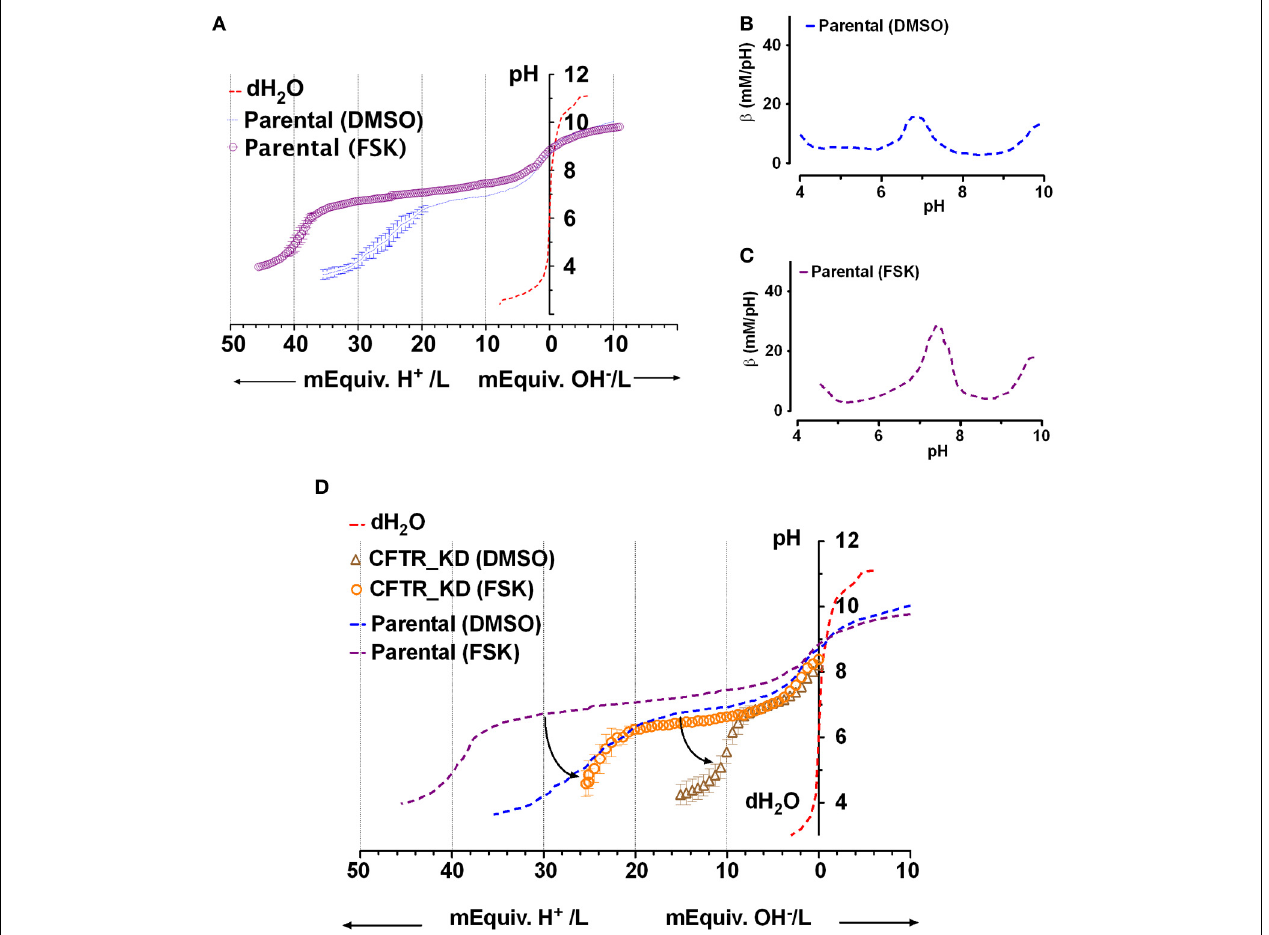
FIGURE 3 | Titration curves for Calu-3 secretions. (A) Microtitration of fluid producedbyparentalCalu-3cellmonolayersunderbasalconditions( (cid:4) ,treated with DMSO vehicle) and during stimulation by 10 μ M forskolin ( (cid:5) ). Dotted line shows the control curve obtained with distilled water. HCl and NaOH were the titrants and were added in increments of 0.4mM final concentration. Means ±